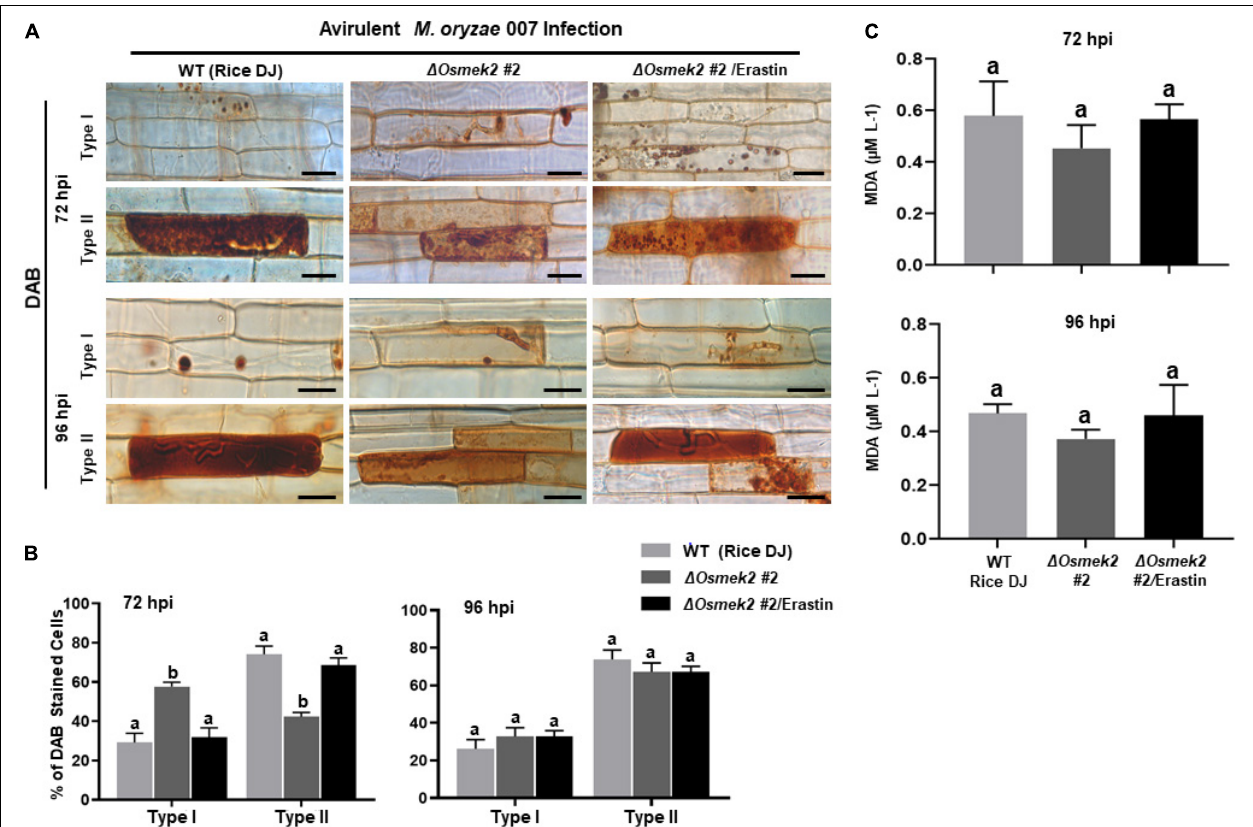
FIGURE 8 | ROS accumulation and lipid peroxidation in leaf sheaths of wild-type (WT) rice (cultivar DJ) and (cid:49) Osmek2 #2 plants at 72 and 96 h after inoculation with avirulent Magnaporthe oryzae 007 with 10 µ M erastin. Rice (cid:49) Osmek2 #2 leaf sheaths were inoculated with conidial suspensions (4 × 10 5 conidia mL − 1 ) of avirulent M. oryzae 007 with and without 10 µ M erastin. Avirulent M. oryzae 007 infection induced ROS production and lipid peroxidation in leaf sheaths of the susceptible (cid:49) Osmek2 plants at 96 hpi, which was similar to those in erastin-treated leaf sheaths of the susceptible (cid:49) Osmek2 #2 plants. (A) DAB-stained cell phenotypes at 72 and 96 h after inoculation. DAB-stained cells were categorized into two phenotypes: Type I, cells that contain invasive hyphae (IH) but are weakly or not DAB-stained; and Type II, strongly DAB-stained cells with only a few poor hyphae. Scale bars = 20 µ m. (B) Quantification of DAB-stained cells at 72 and 96 h after inoculation. DAB-stained cells were categorized into two phenotypes: Type I, infected cells that display no or weak DAB staining; Type II, infected cells that display strong DAB staining. (C) Determination of lipid (MDA) peroxidation in rice leaf sheaths at 72 and 96 h after inoculation. Results are presented as mean values ± SD; n = 4 leaf sheaths from different plants. Images were captured using a fluorescence microscope (Zeiss equipped with Axioplan 2). Results are presented as mean values ± SD; n = 4 leaf sheaths from different plants. Different letters above the bars indicate significantly different means ( P < 0.05) as analyzed by